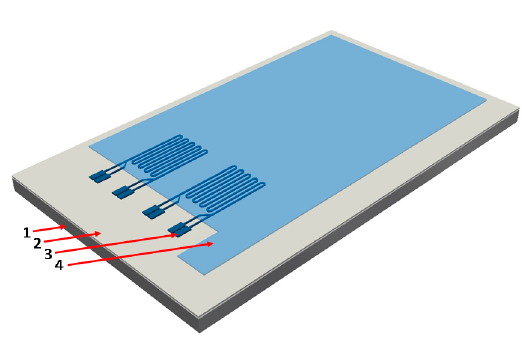
Figure 1. Schematic of printed strain gauges (3) on top of organic precoated (2) sheet steel (1), with an additional top coating layer (4) for mechanical protection and stabilization. The sensor layer (3) is fabricated either with screen-printing, for silver and carbon black, or deposited via PVD for